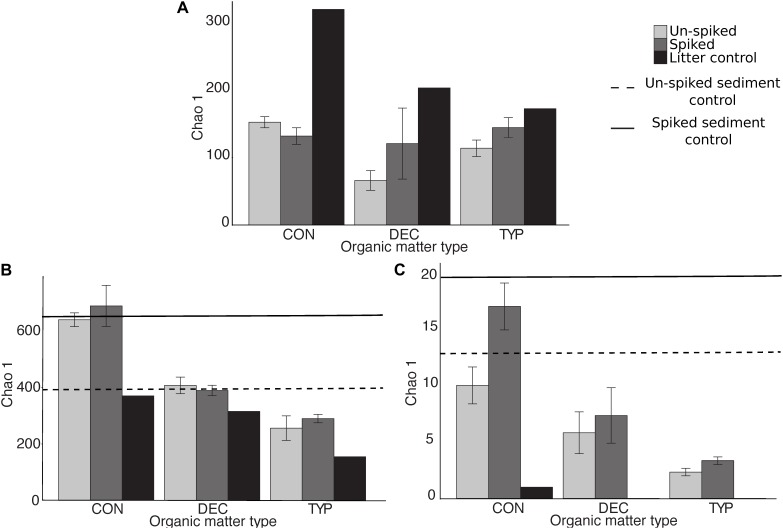
Mean diversity (±SE) of bacterial (A), fungal (B), and methanogen (C) communities for each plant litter type. Diversity was calculated as Chao 1 values averaged for each plant litter type added to either the un-spiked or spiked amended sediments and pre-incubation plant litter controls. Bacterial values for both the un-spiked and sediment control were 975.5 (±77.5) and 1360.5 (±111.5), respectively, and beyond the y-axis limits therefore not included in the figure. SE for fungal un-spiked sediment control was ±6 and ±171 for the spiked, and ±3.5 and ±0.5, respectively, for methanogens.